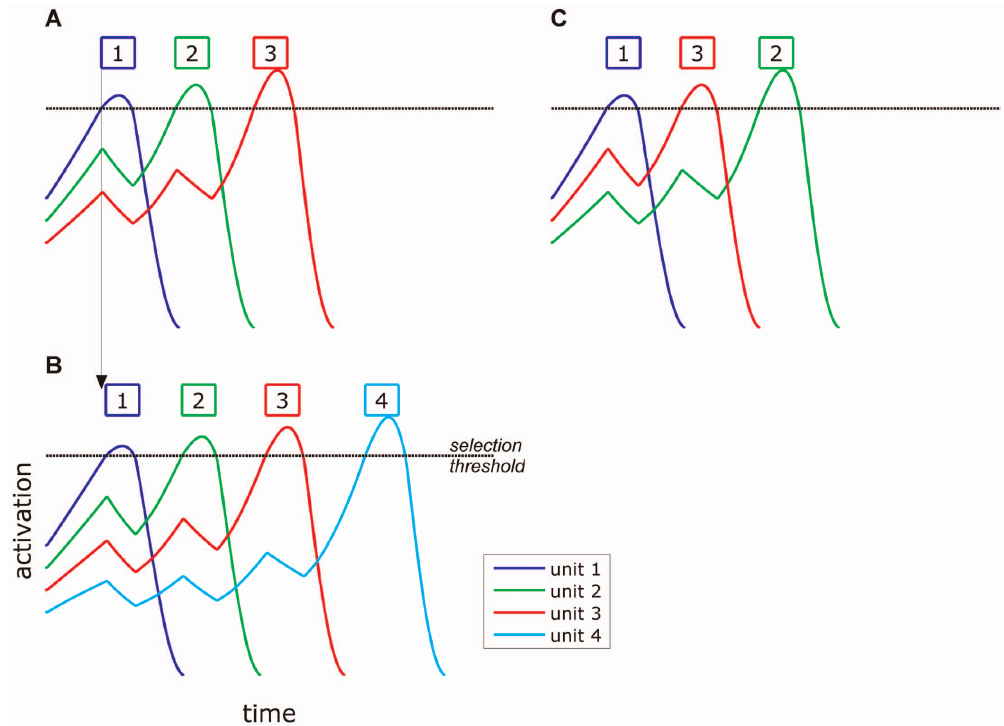
Figure 3. Competitive selection model dynamics. (A) competitive selection of three units. (B) competitive selection of four units, with movement initiation delayed relative to (A). (C) Sequencing error in which unit 3 is selected early.